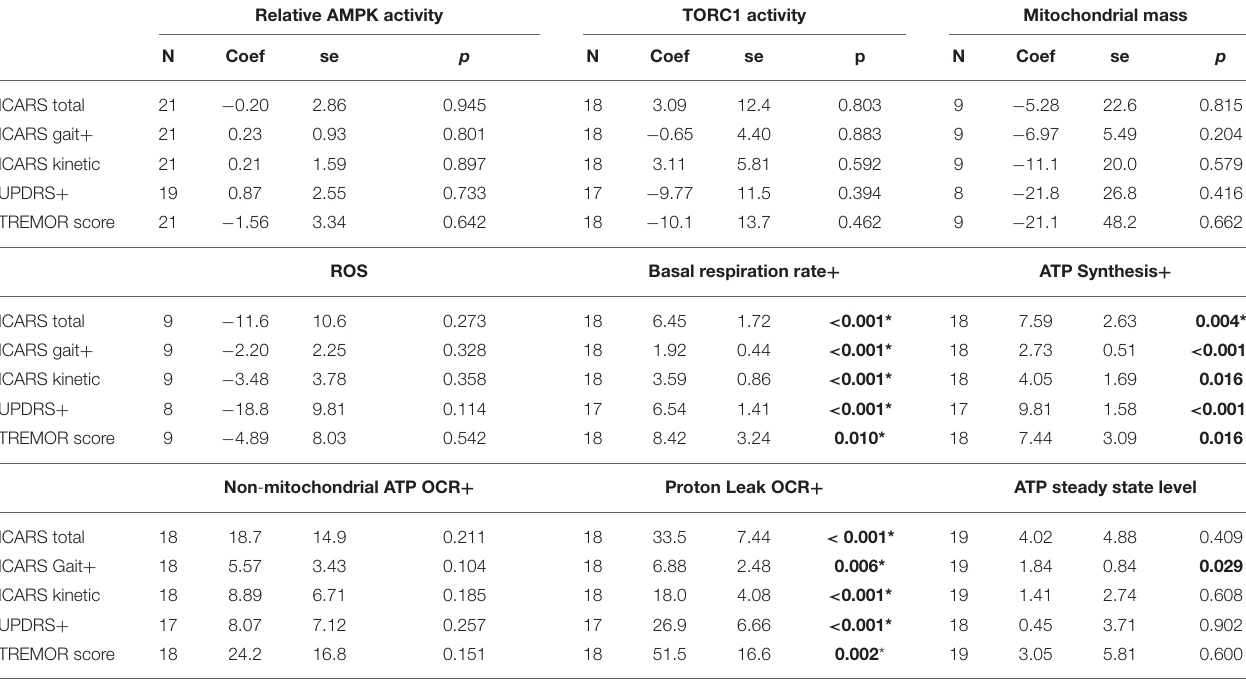
TABLE 3A | Relationships between motor scores and cellular stress sensing and bioenergetics measures in FXTAS sample. Relative AMPK activity TORC1 activity Mitochondrial mass